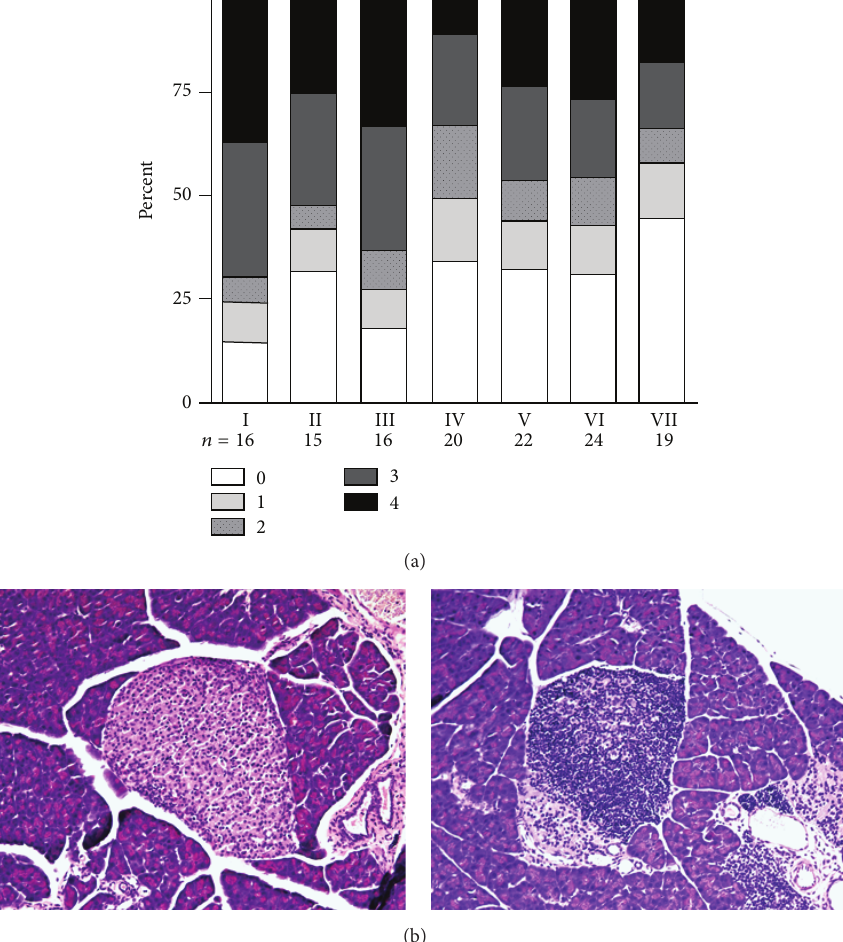
Figure 3: (a) Insulitis score in the experimental groups. (b) Microphotograph of normal islet (left) and severely infiltrated islet (right, corresponding to stage 3) in each group. Groups IV–VII differ from Groups I–III ( 𝑝 < 0.001